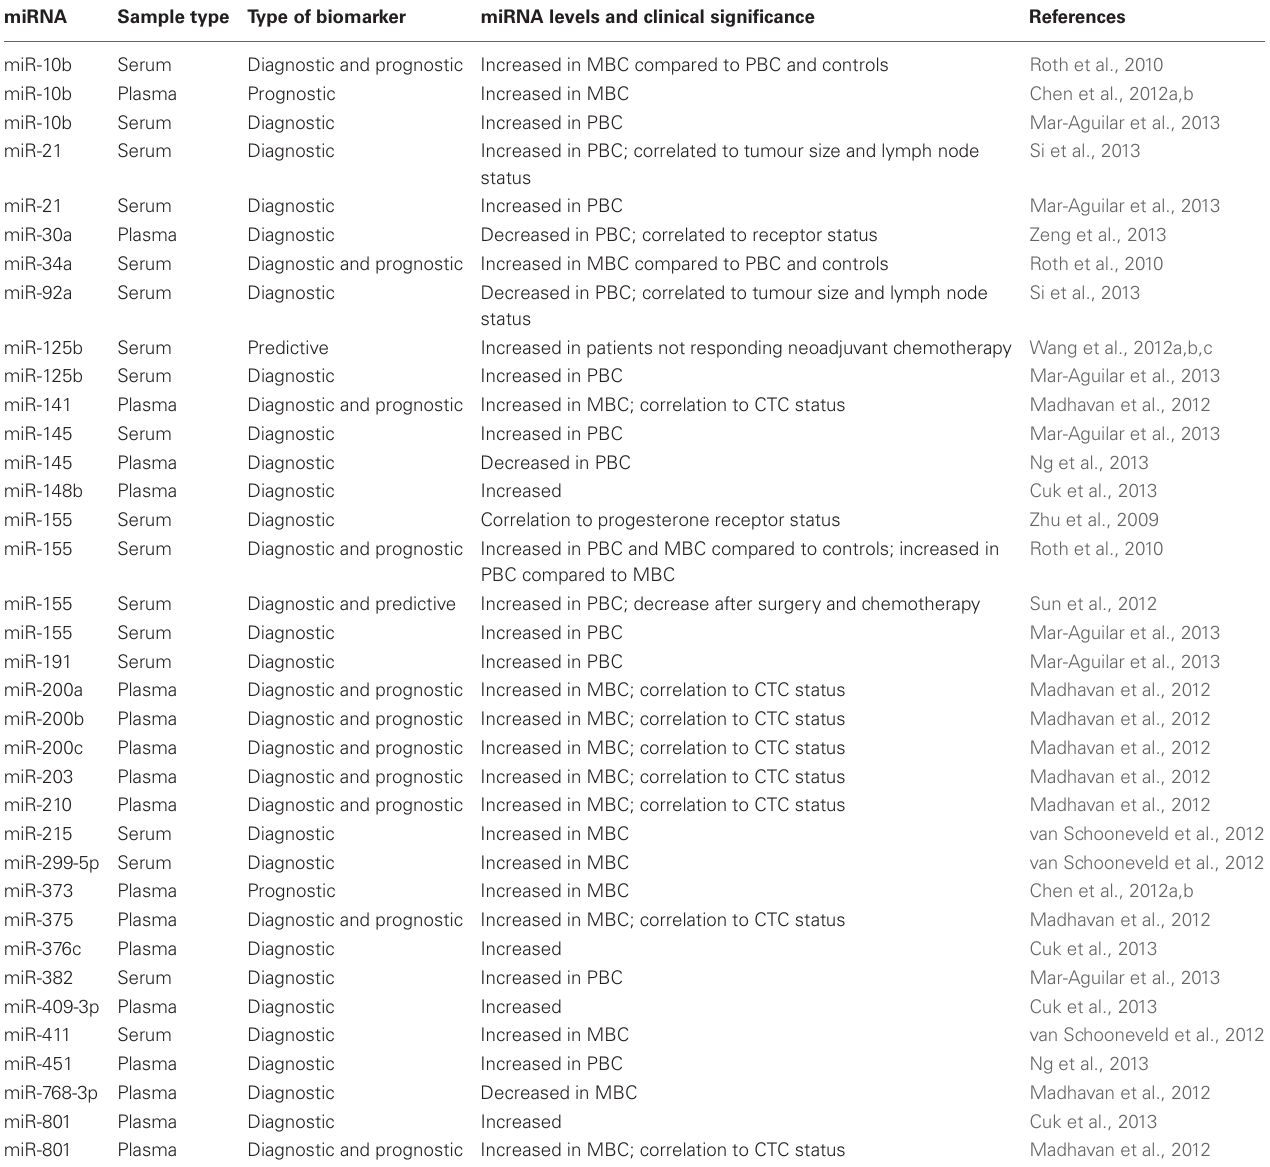
Table 2 | Circulating miRNAs reprted to be a biomarker for breast cancer.